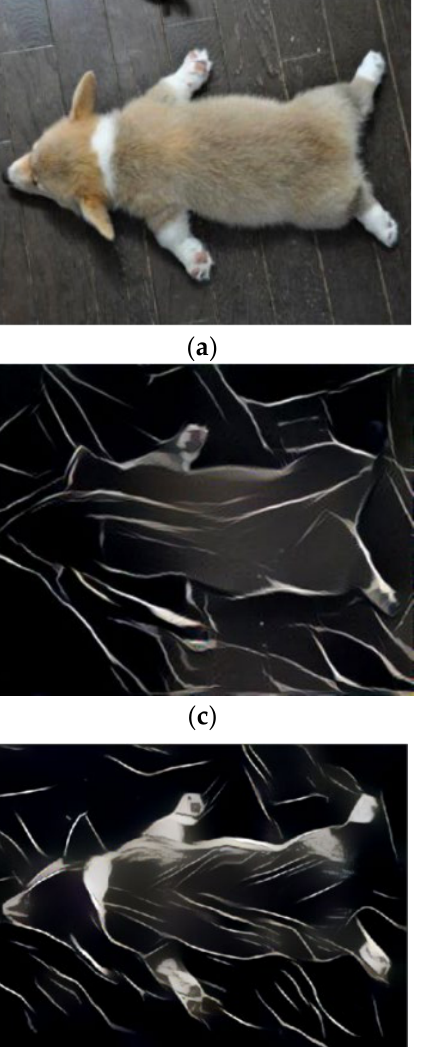
( e ) Figure 21. The comparison of the methods of Gatys et al., X. Li et al., and the proposed method. ( a ) Content image. ( b ) Target image. ( c ) The results of Gatys et al.’s method. ( d ) The results of X. Li et al.’s method. ( e ) Our result. 5. Conclusions The proposed method is a deep learning image transfer technique based on the color transfer method. In this paper, the distribution of luminance was used to segment the image, and then the color transfer was performed for different regions. The image color transfer method proposed in this paper is a local color transfer, so it can improve the re-